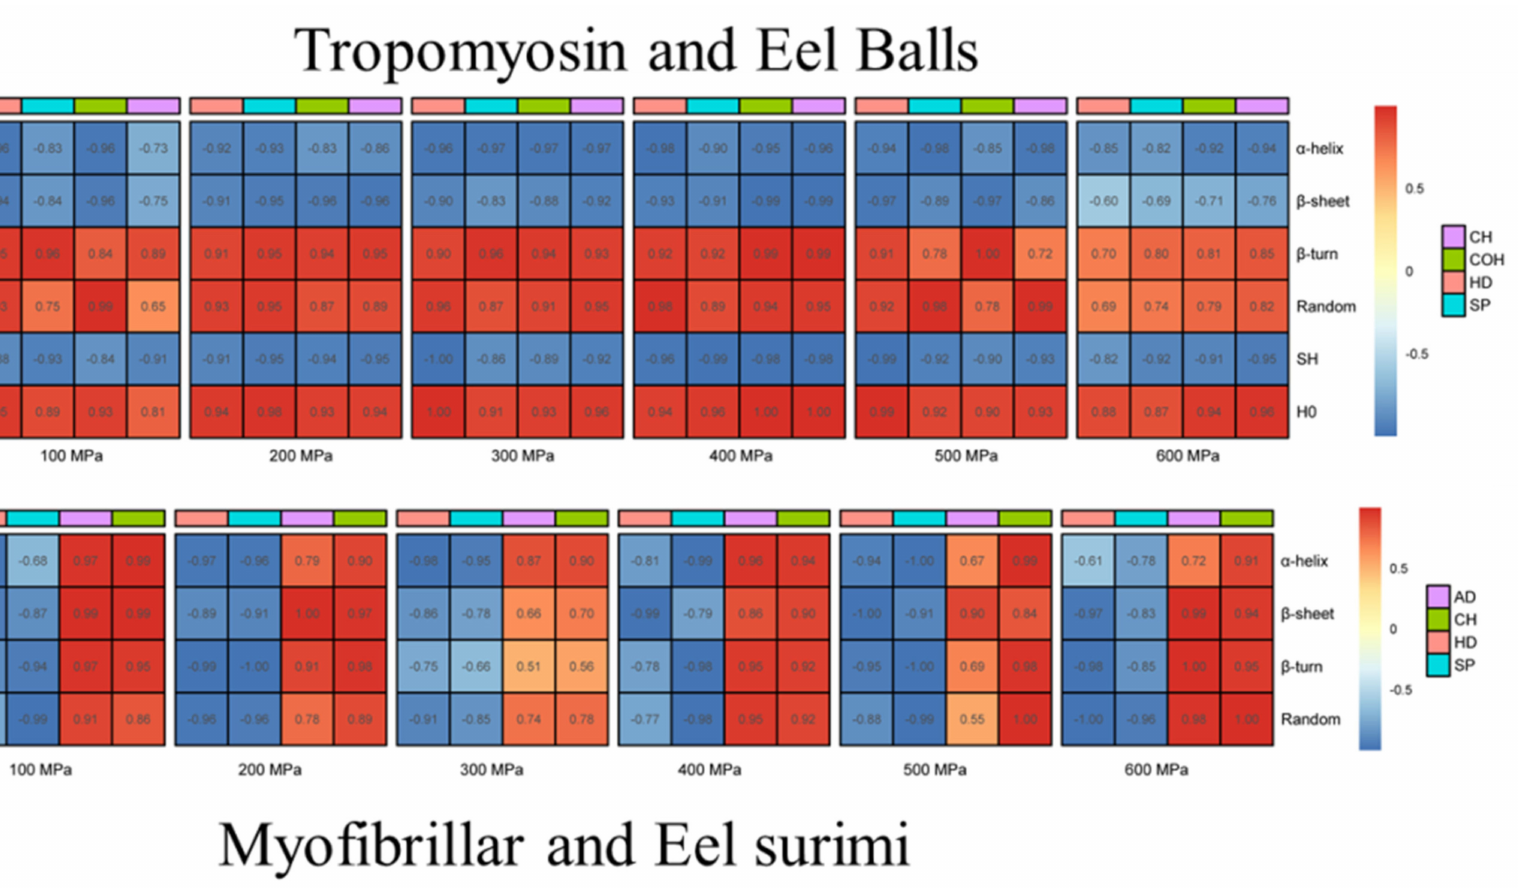
Figure 3. Correlation analysis of tropomyosin and Eel balls/myofibrillar protein and eel surimi (in our